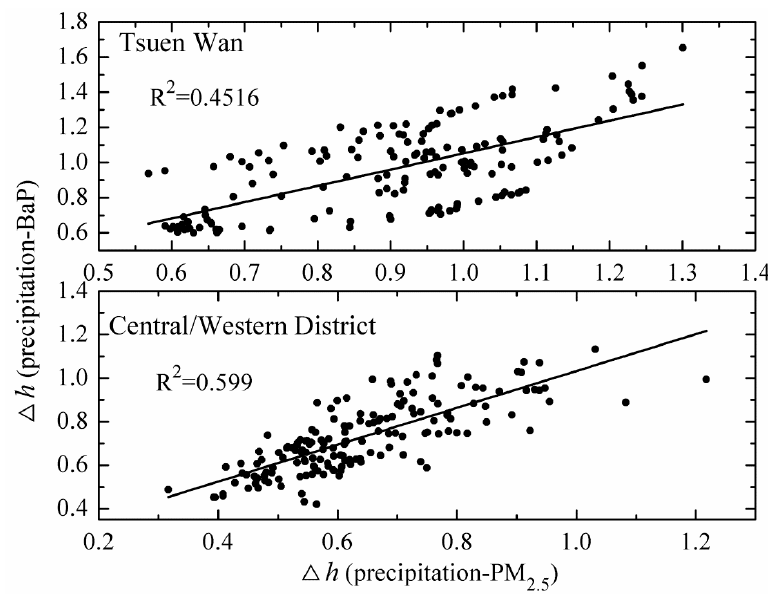
Figure 5. The correlation coefficient between Δ h (PM 2.5 –precipitation) and Δ h (BaP–precipitation).